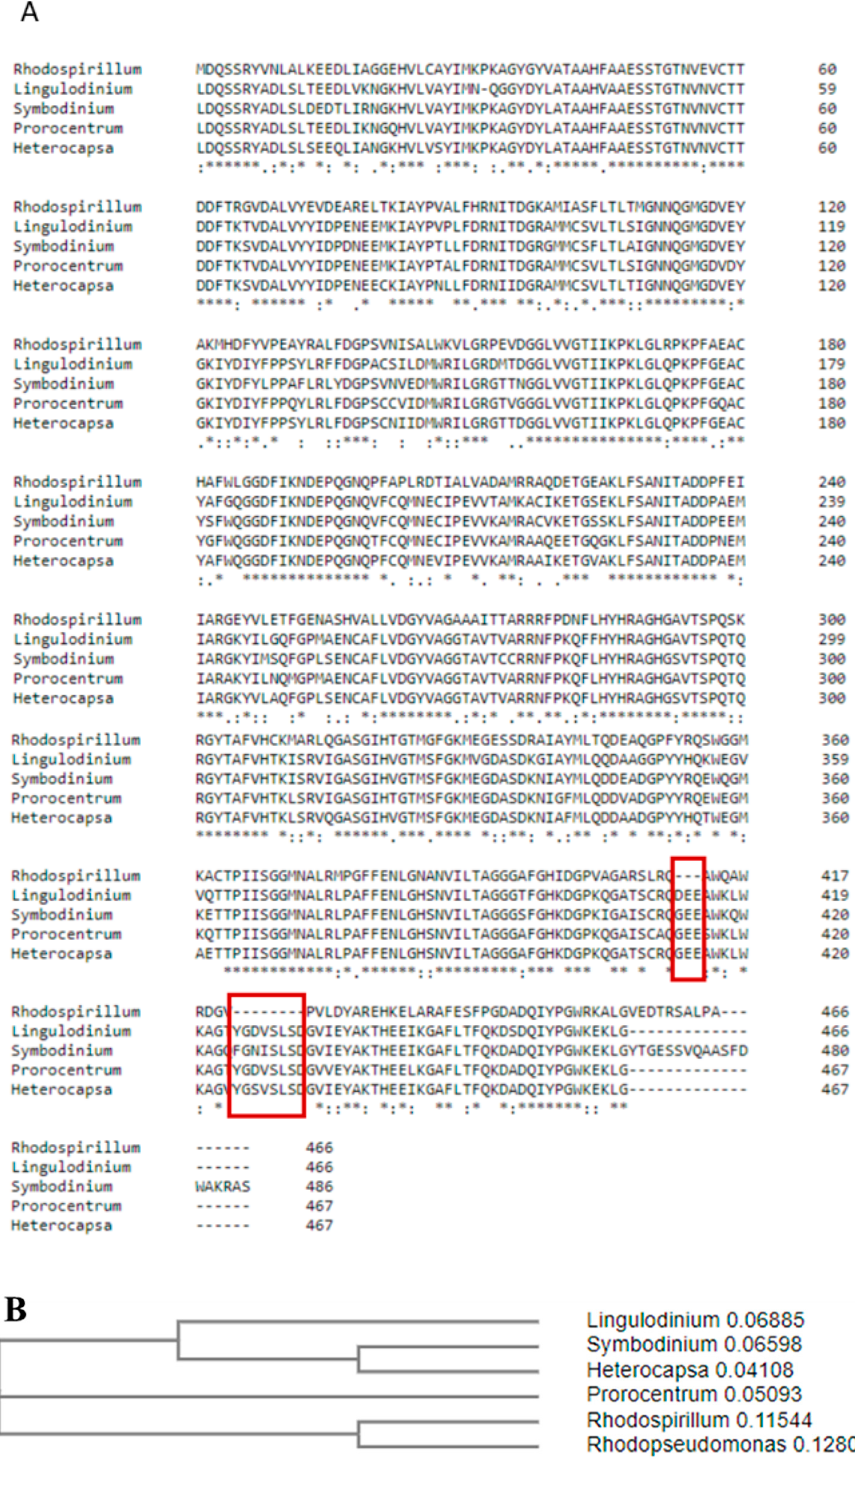
Figure 1. Protein sequence alignment in Clustal OMEGA ( A ) and a phylogenetic tree of form II Rubiscos from Dinoflagellates constructed based on this alignment ( B ). Red frames indicate the position of two unique inserts. “*” indicate identical amino acids in all sequences, “:” indicate amino acids which are not identical but have similar properties.